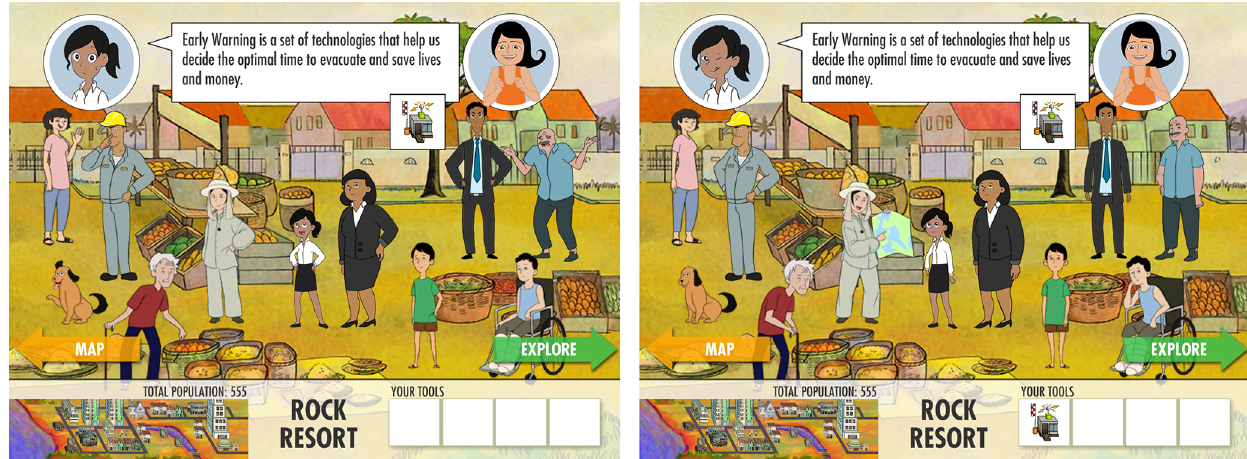
Figure 6. In some of the market interactions the villager’s statement suggests using a specific tool, and her facial expression changes when the player agrees to add the tool to the temporary toolbox in the lower right.